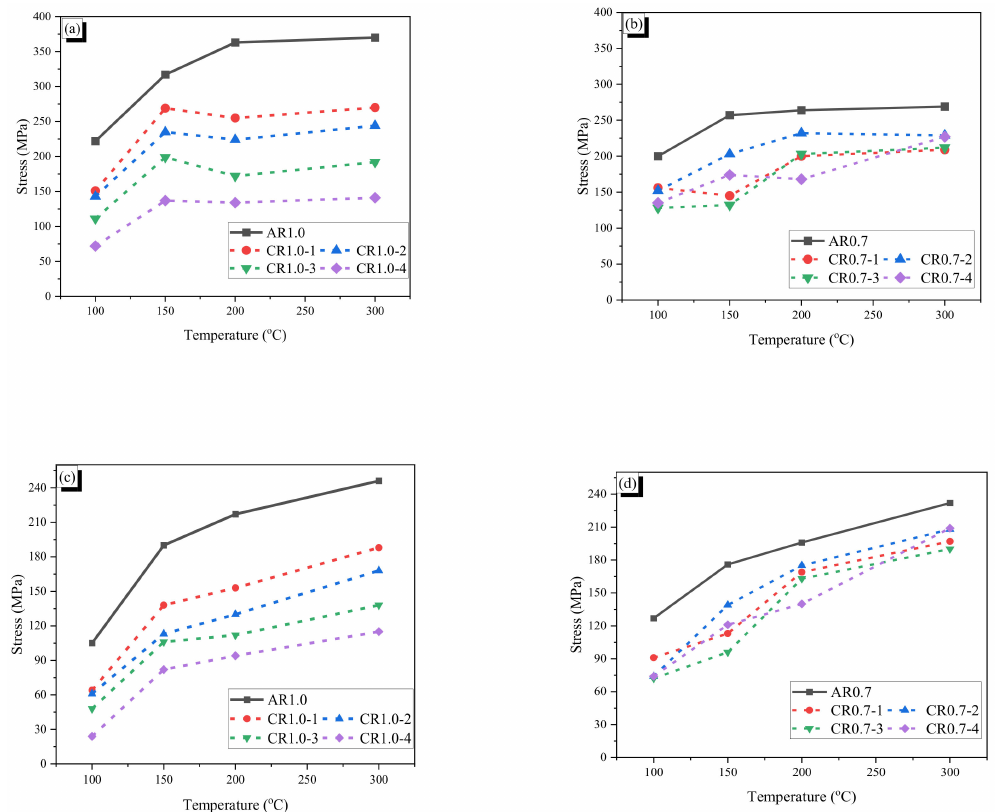
Figure 9. The comparison of the max recovery stress and the residual stress: ( a ) max. recovery stress of 1.0-mm diameter fibers; ( b ) max. recovery stress of 0.7-mm diameter fibers; ( c ) residual stress of 1.0-mm diameter fibers; and ( d ) residual stress of 0.7-mm diameter